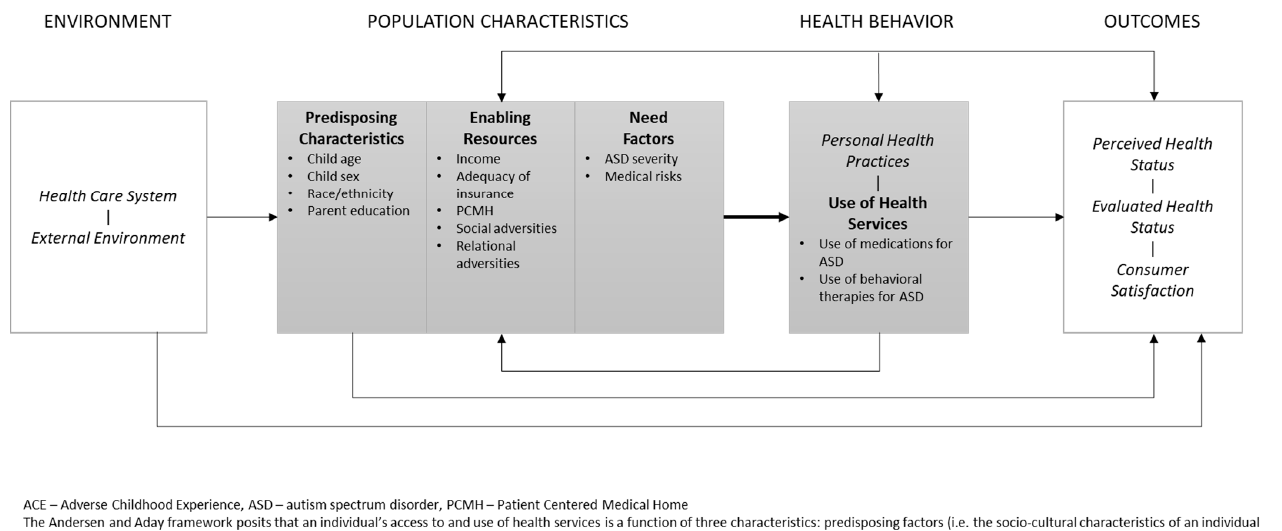
Figure 1. Application of the Andersen and Aday Framework of Health Services Utilization.